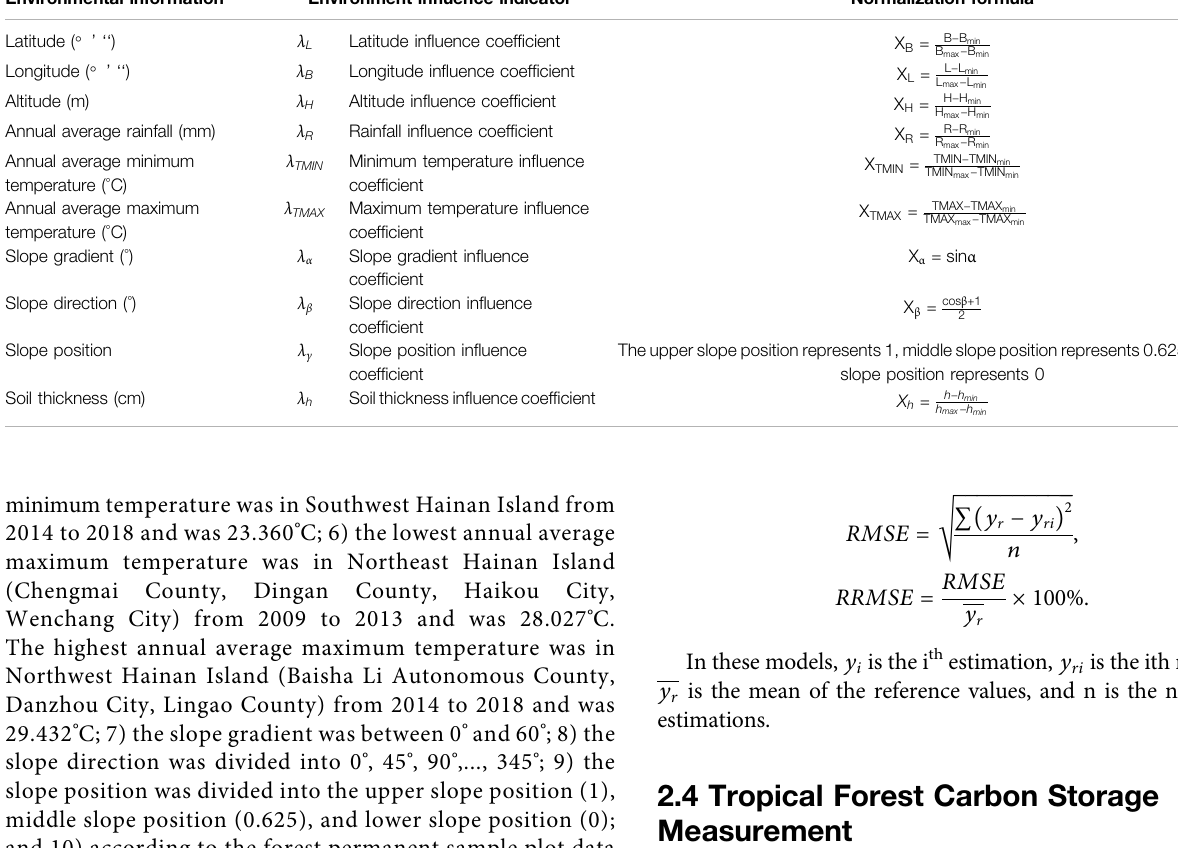
TABLE 2 | Normalization formulas of the 10 environmental information variables. Environmental information Environment in fl uence